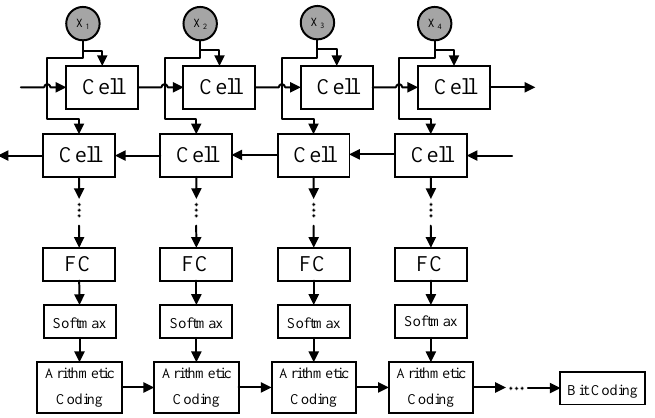
Figure 1. Proposed deep lossless compression algorithm framework. The upper part of the figure is the bilstm model, which includes bidirectional neurons, FC layer, and softmax layer. The lower part is Arithmetic Coding and Bit Coding.